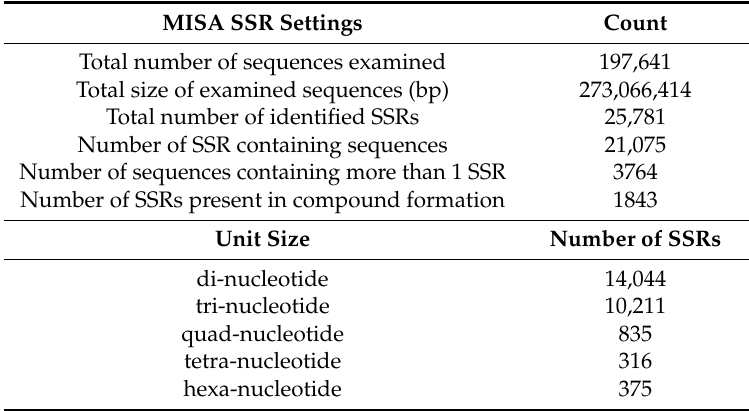
Table 3. Single sequence repeats (SSR) marker results.